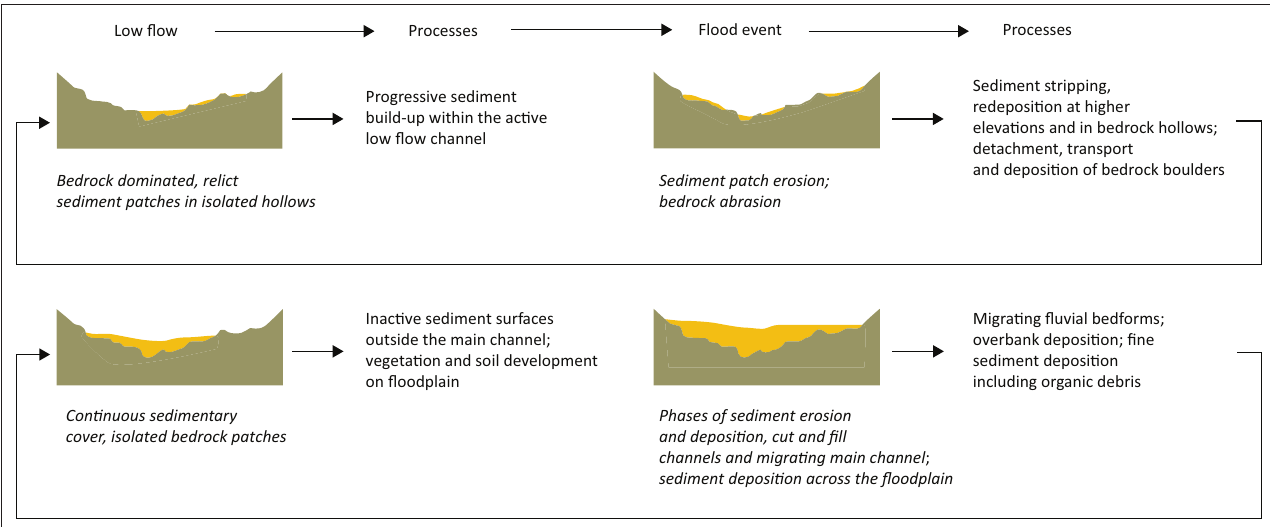
FIGURE 2: Conceptual process model of the evolution of bedrock-dominated (top) and sand-dominated river channels (bottom) in the Sabie River during low flow and then flood conditions. Note that this then returns to low flow conditions afterwards. A schematic cross-section of the river profile is presented, with bedrock (brown) and sediment areas (yellow)